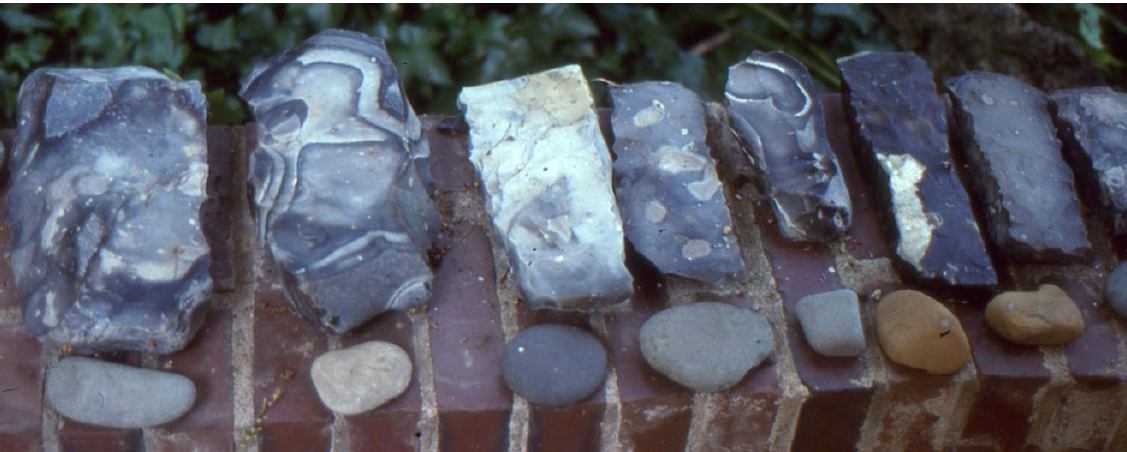
Figure 3. Early stages of manufacture and finished products of square edge Neolithic Danish axes. (Photo H. G.